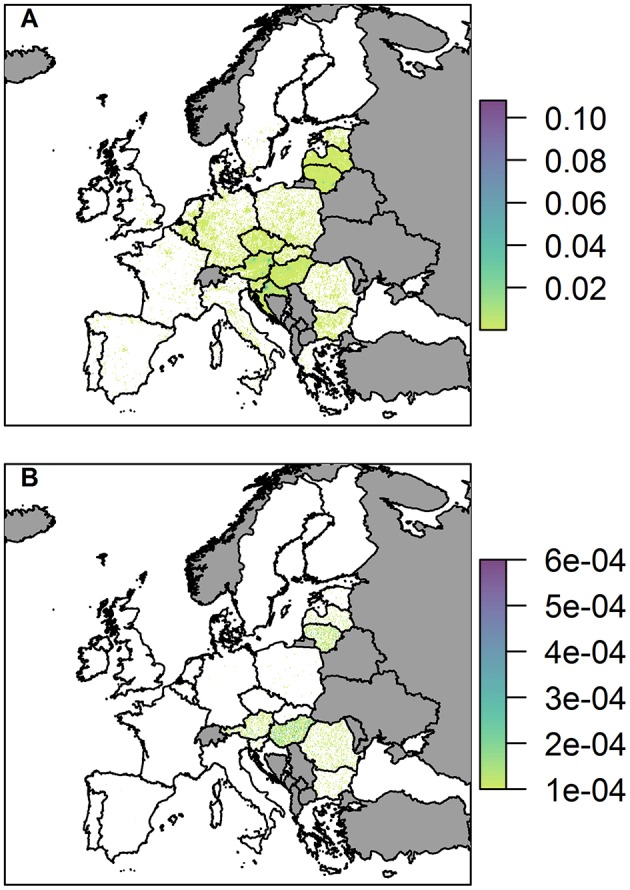
The probability of at least one infection of ASFV in 2019 in (A) wild boar and (B) pigs, via trade in legal pig meat products, plotted at a 100 km2 cell level across Europe. Countries in gray have insufficient data to complete the risk assessment.